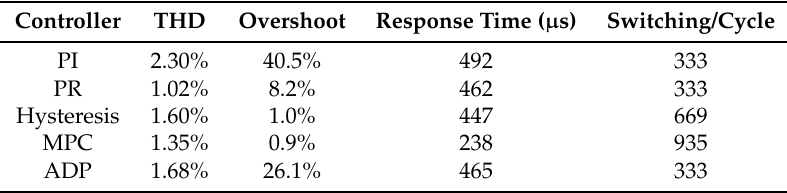
Table 2. Performance comparison of current